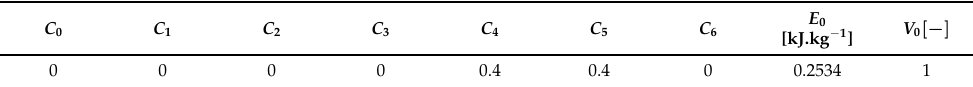
Table 2. Parameters for linear polynomial EOS for the air.